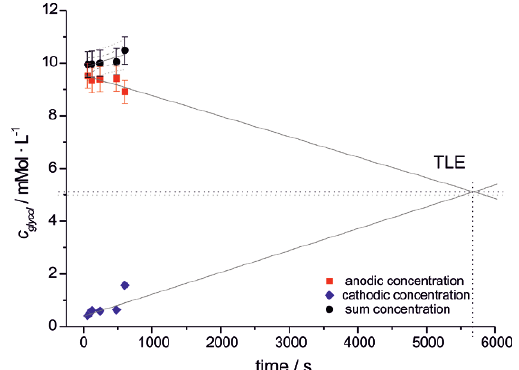
Figure 16. Exp. 4b: Transport of glycol from cathode to anode beaker. The grey dashed line marks the theoretical mixture concentration (5 mM); the black dashed lines show concentration and time at the theoretical linear equilibrium (TLE). The concentration sum is evaluated with a linear fit including 95% confidence (dashed) and 95% prediction (dotted)